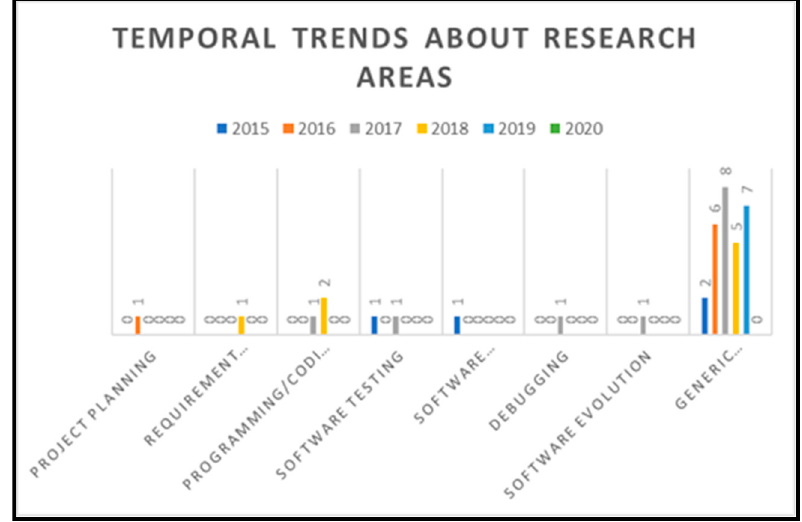
Figure 4. Temporal research trends about focused research areas (software development).